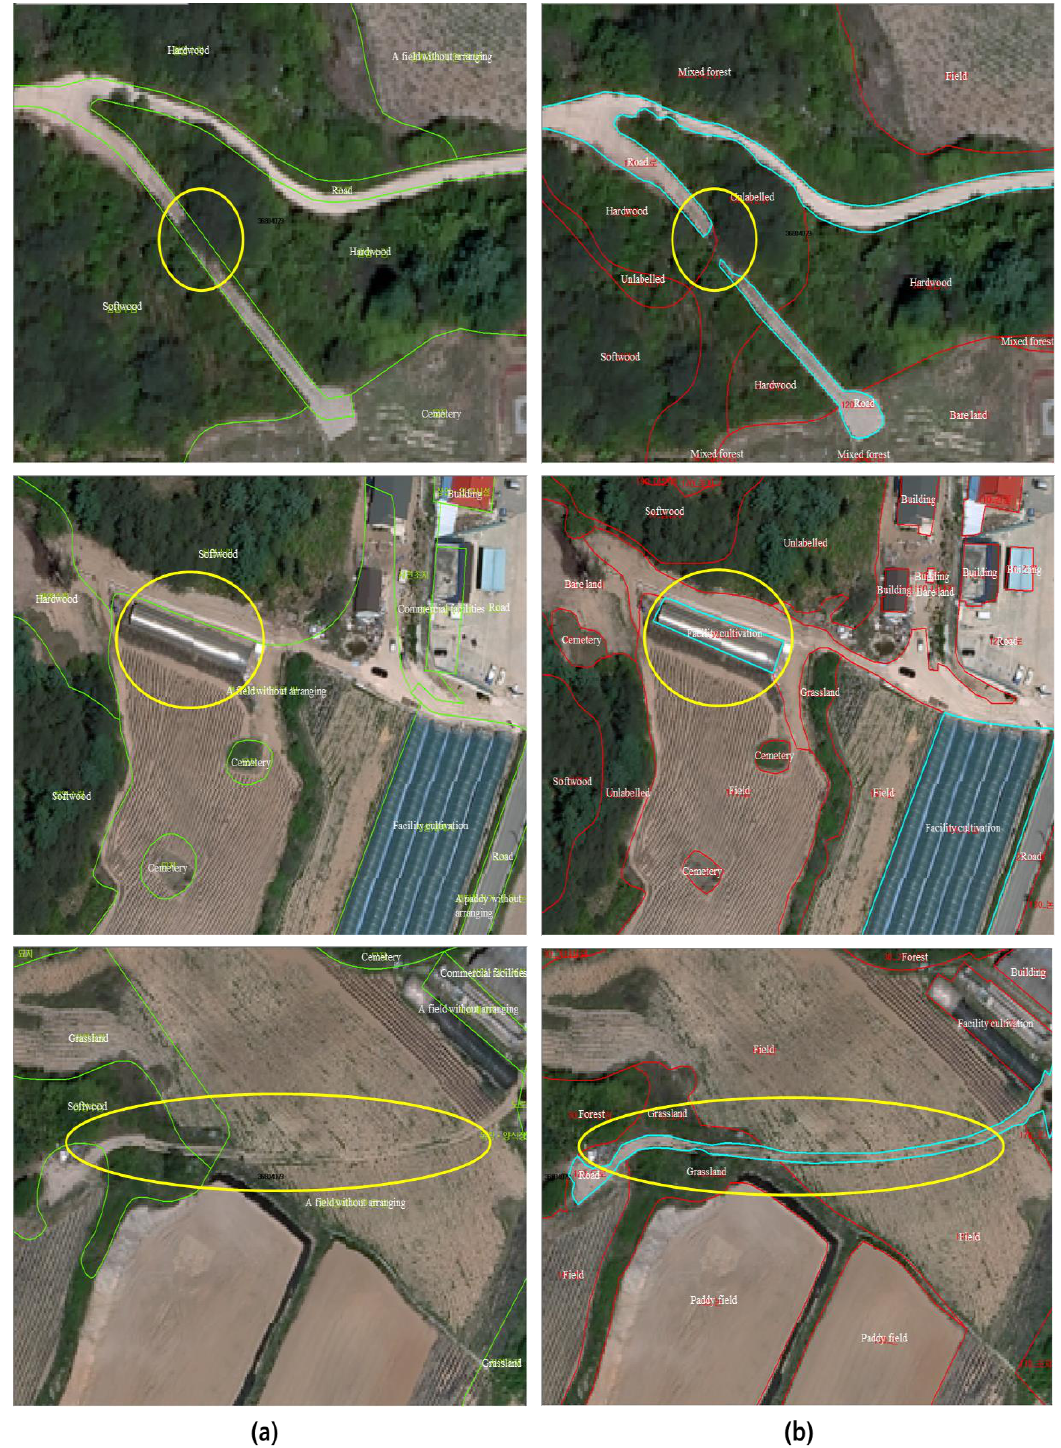
Figure 6. Example of revised label. ( a ) is an example of an area to be revised and ( b ) is after revision.